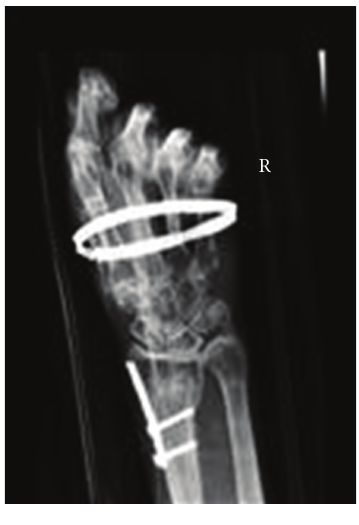
neurological symptoms and